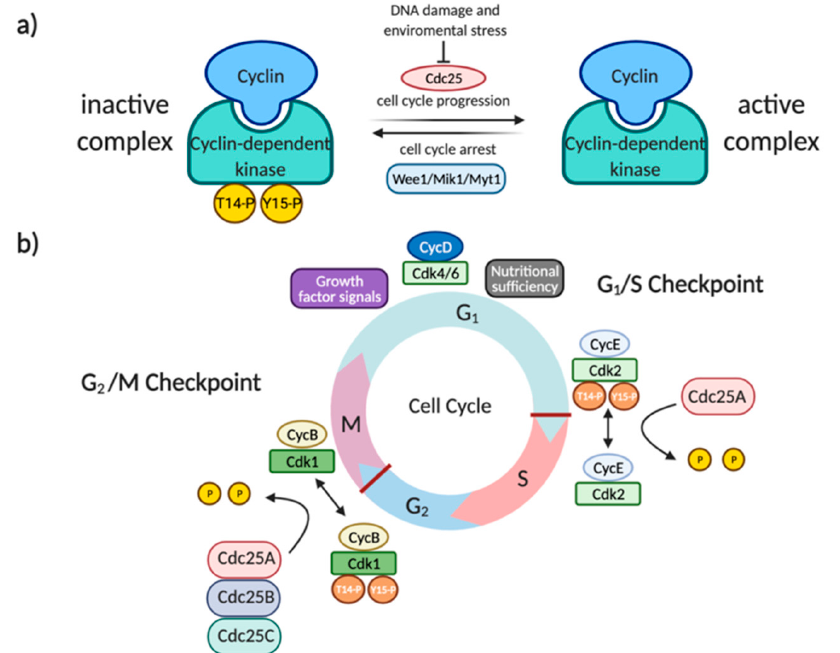
Figure 1. ( a ) Inactivation of cyclin-dependent kinases (Cdks) by the Wee1/Mik1/Myt1 protein kinase family through the phosphorylation of T14 and Y15. ( b ) The promotion of the entrance of cell division cycle 25 A (Cdc25A) in the S-phase cell cycle through the activation of the Cdk2/CycE complex (on the right); the promotion of mitosis by Cdc25A-B-C through the activation of the Cdk1/CycB complex (on the